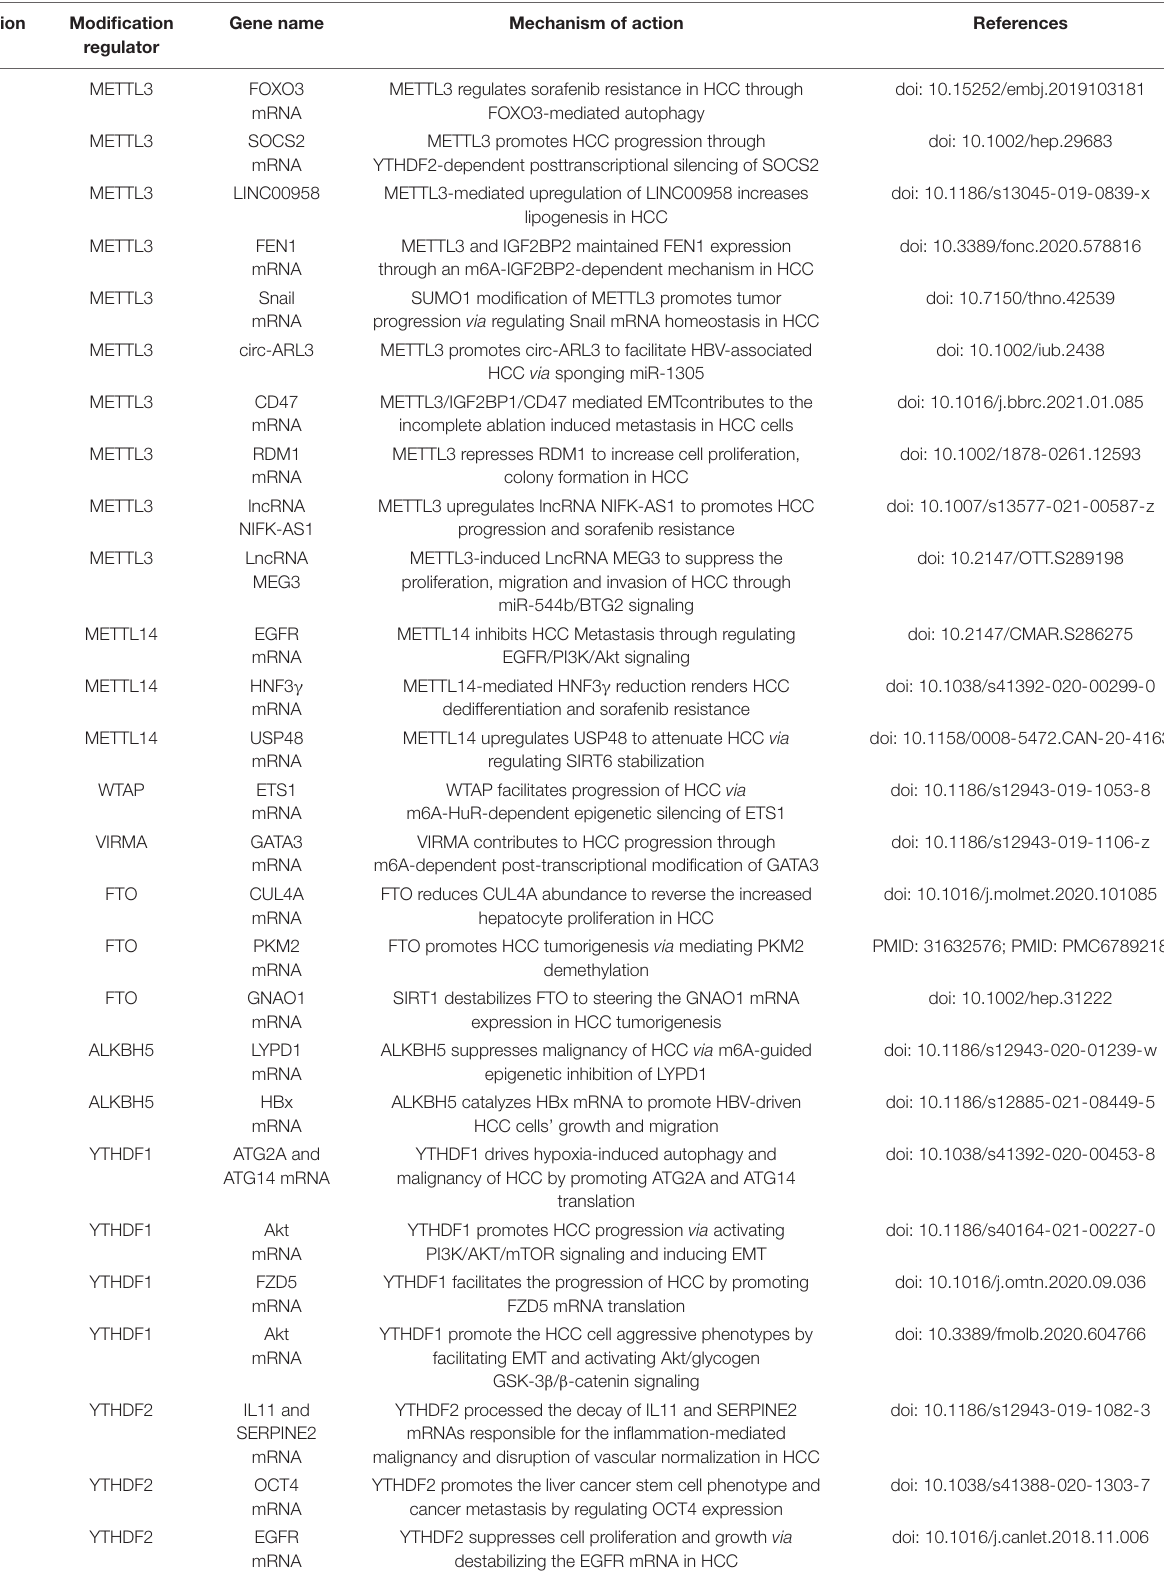
TABLE 1 | A summary of known RNA epigenetic modifications and potential targets in